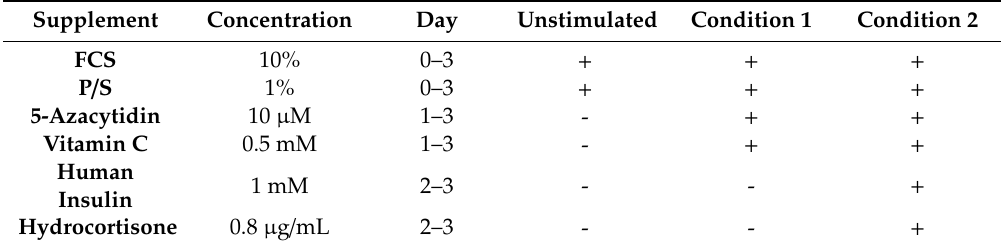
Table 2. Compounds of stimulation medium, and timeline of